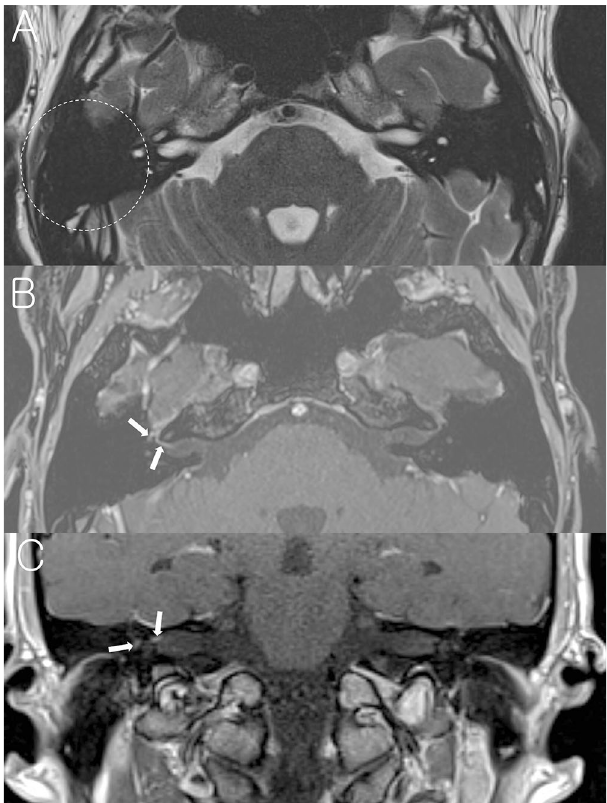
Figure 1. A representative case of the right Bell’s palsy with normal mastoid cavity in temporal bone MRI. ( A ) Non-contrast axial T2-weighted image shows normal mastoid cavity on the right side (dotted circle). ( B ) Post- contrast axial T1-weighted image at the Bill’s bar shows enhancement of the distal canalicular, labyrinthine, genu and proximal tympanic segment of the right facial nerve (arrows). ( C ) Post-contrast coronal T1-weighted image at the level of IAC demonstrates enhancement of the right facial